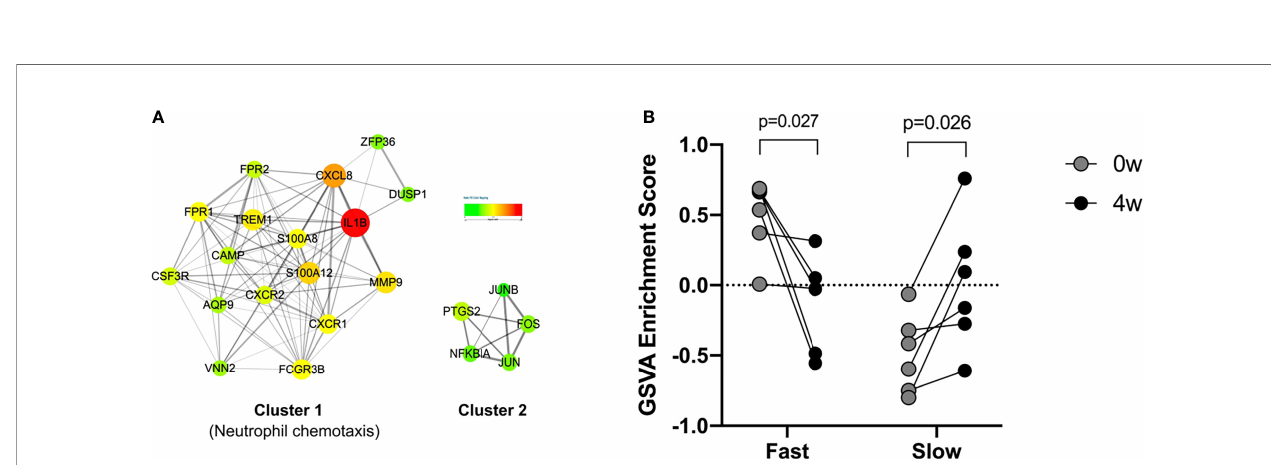
FIGURE 5 | PPI network and GSVA analyses. (A) Protein-protein interaction (PPI) network of in fast responders with psoriasis patients. (B) GSVA analyses for the 17